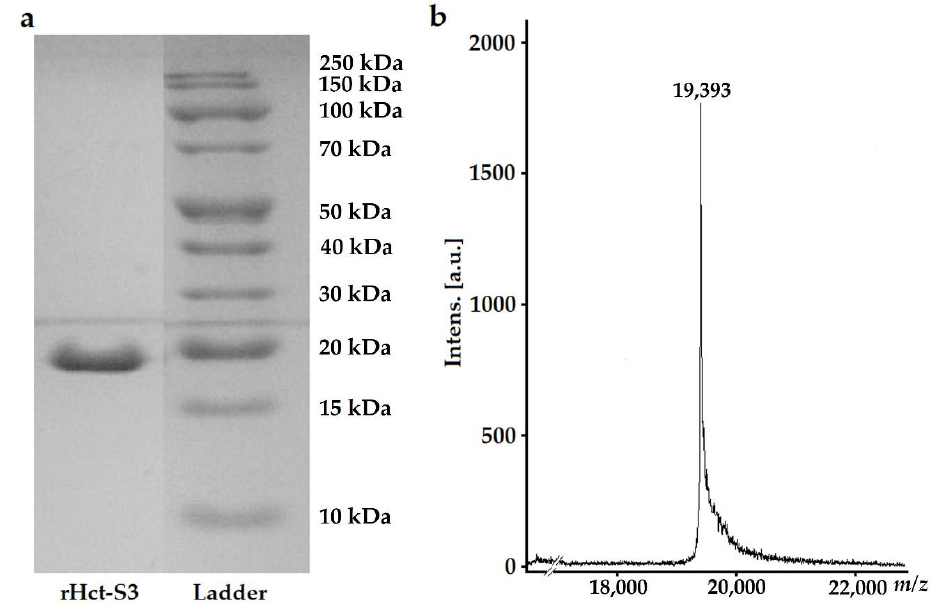
Figure 1. Electrophoregram ( a ) and mass spectrum ( b ) of purified rHct-S3.